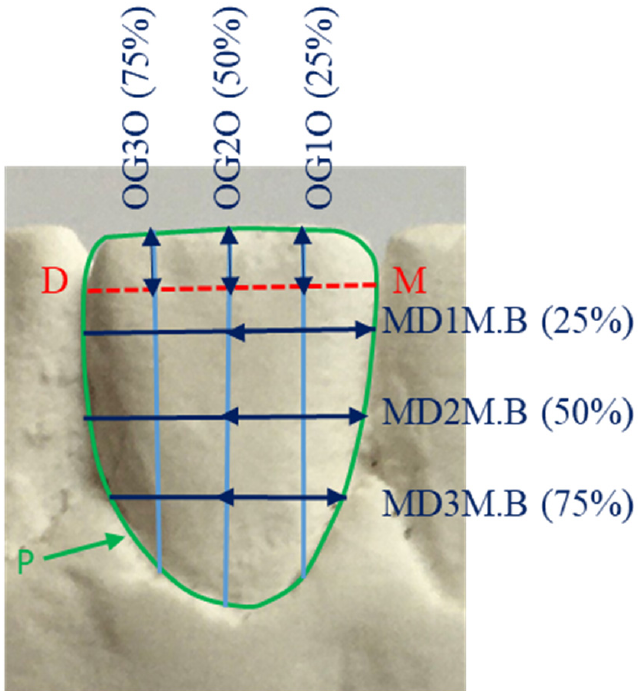
Figure 1. Buccal view of a lower right central incisor measurements: MD: maximal mesio ‐ distal di ‐ mension at the contact points; MD1.B, MD2.B, MD3.B are mesio ‐ distal dimensions at 25, 50 and 75% along a line bisecting the MD, respectively; OG1, OG2, OG3 occluso ‐ gingival dimensions, at 25, 50 and 75% along the MD, respectively; P is tooth surface perimeter.